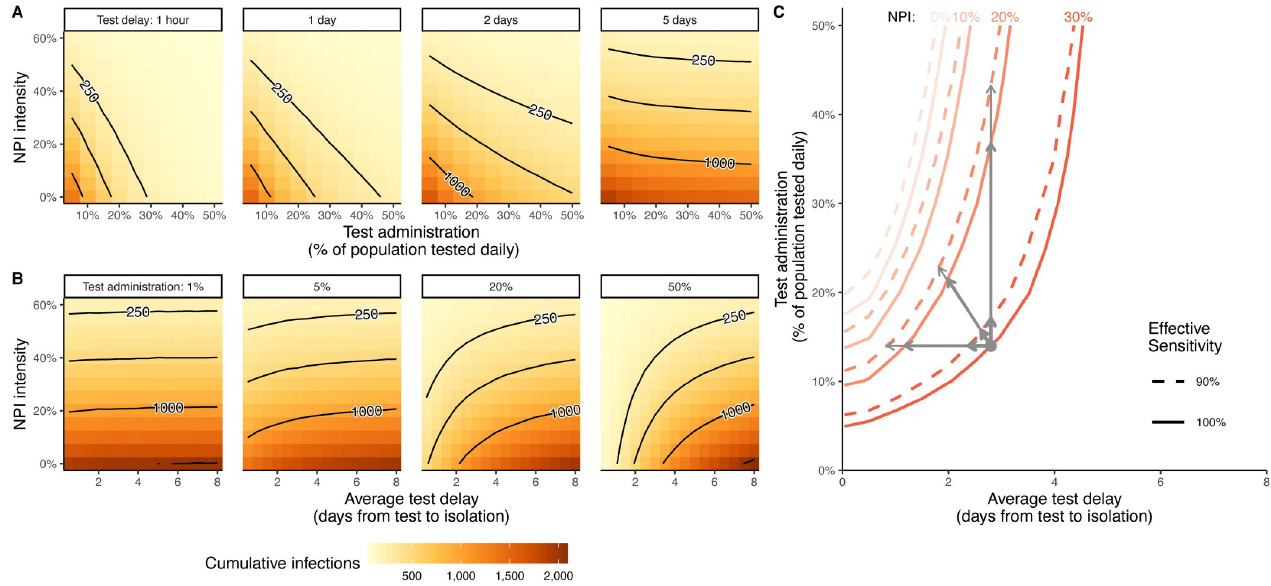
Fig 2. Efficacy of combined interventions including preventative NPIs (e.g., masking, distancing, lockdowns) and testing and isolation. Infections in the 30 days after intervention change (represented as a median of 5000 stochastic simulations) are shown across non-pharmaceutical intervention (NPI) intensities both when test delays are fixed (A) and test administration is fixed (B) for several sample values. In both, isoclines are shown for 250, 500, and 1000 infections, representing potential threshold levels of median infections that a local system can tolerate. Similarly, the test delay and administration required to achieve a given NPI intensity (C) are shown for four potential NPI intensities (line color) across two possible effective test sensitivities (line type; solid = 100%, dashed = 90%), all assuming 500-infection threshold levels (contours for 250- and 1000-infection thresholds shown in S2 Fig). Grey arrows represent sample policy movements between interventions that maintain public health outcomes, where moves can be made by increasing testing administration (vertical arrows), decreasing test delays (horizontal arrows), or a combination (diagonal arrows). Moves can maintain NPI intensity with a less sensitive test (thick arrows), decrease NPI intensity with the same test (medium arrows), and decrease NPI intensity with a less sensitive test (light arrows). See S3 Fig for a version of this figure showing results when individuals who report for testing are assumed to wait for a test result to isolate.